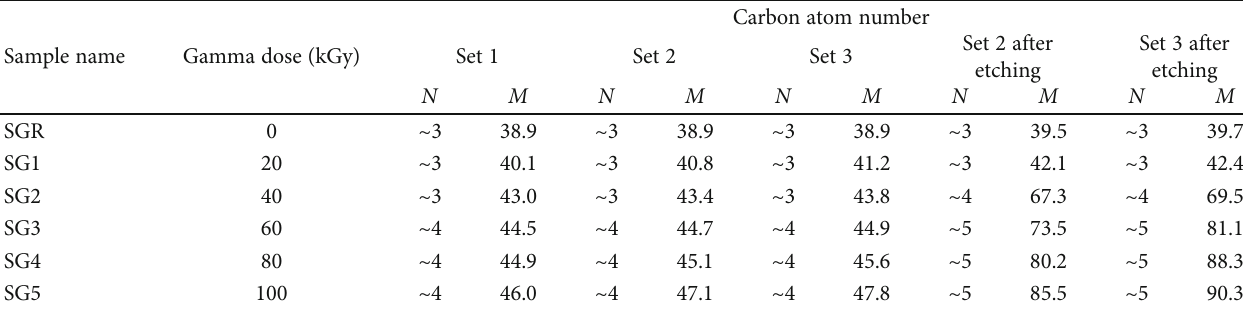
Table 4: The calculated value of N and M